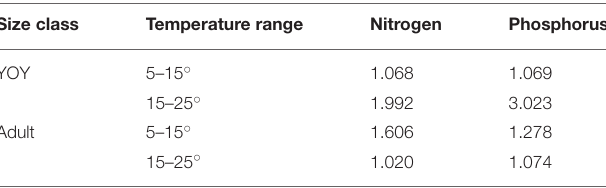
TABLE 1 | Q 10 values for N and P decay rates through 38 days of the laboratory